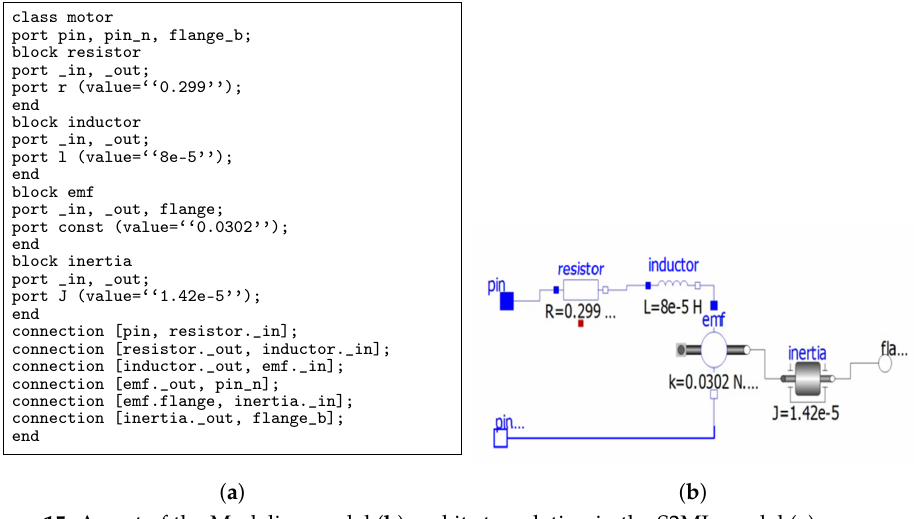
Figure 15. A part of the Modelica model ( b ) and its translation in the S2ML model ( a